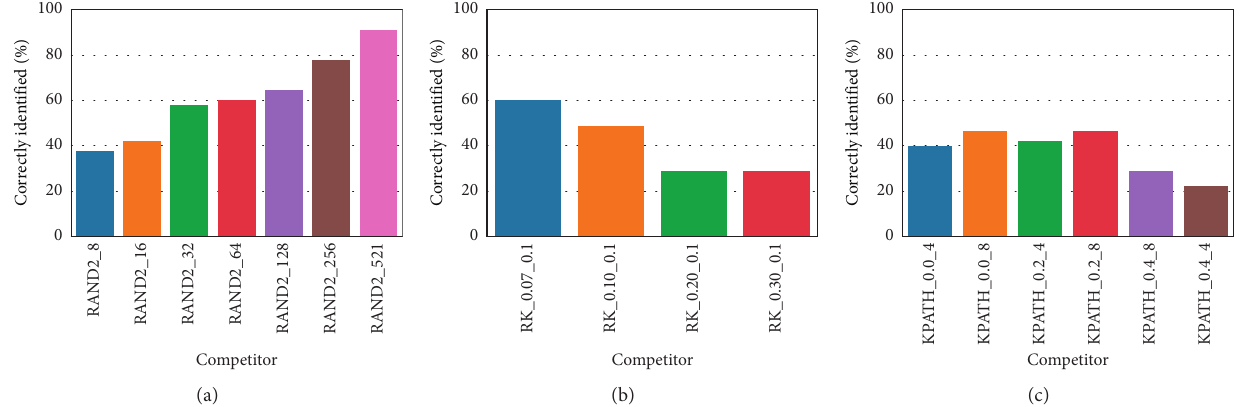
Figure 5: Top-1-Hits of different static betweenness approximation techniques on random networks. (a) RAND2. (b) RK. (c) KPATH.